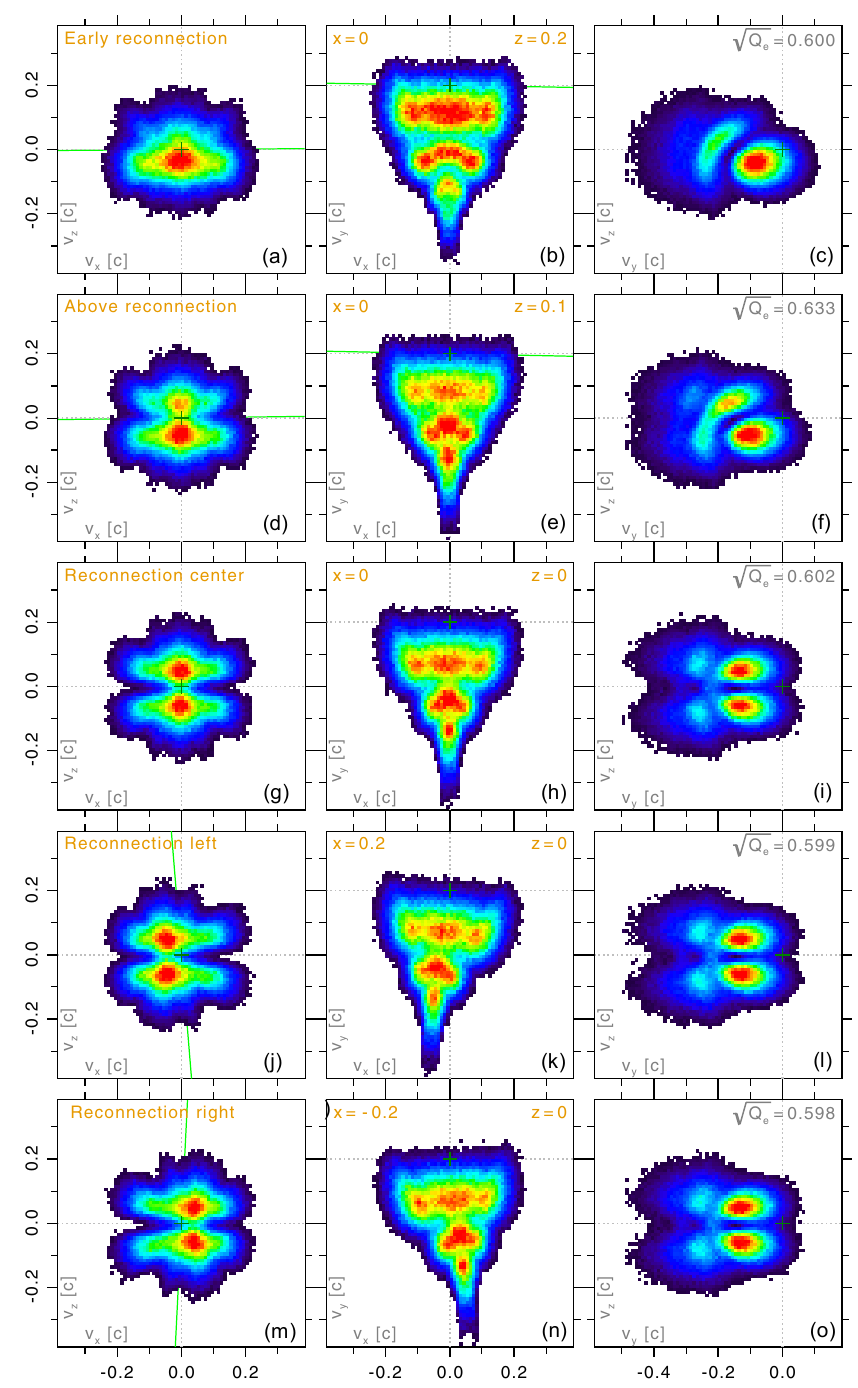
Figure 6. Same as Fig. 5 but around the electron diffusion